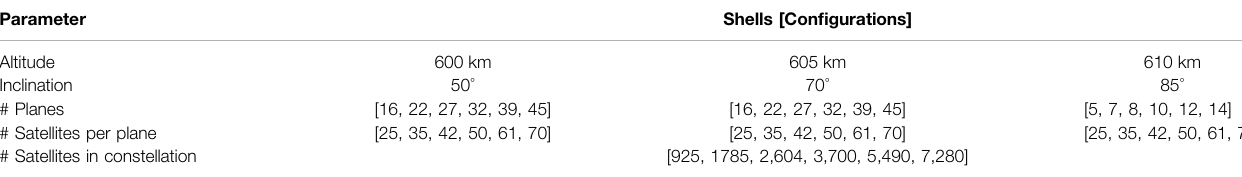
TABLE 2 | Simulated satellite